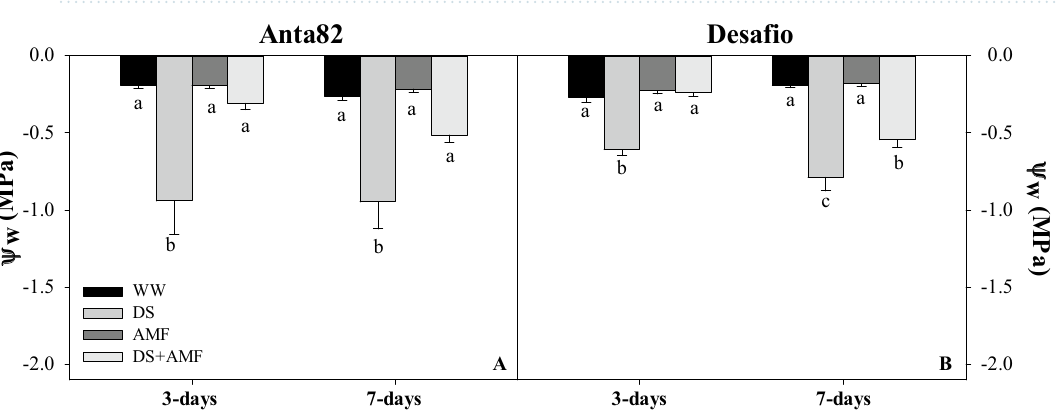
Figure 3. Water potential (Ψ w ) on days 3 and 7 in the ( A ) Anta82 and ( B ) Desafio soybean cultivars under different conditions of inoculation and water stress. WW = well-watered, noninoculated, DS = drought stress, noninoculated, WW + AMF = well-watered and inoculated, DS + AMF = drought stress and inoculated. The bars represent the mean ± SEM ( n = 4). Pairs of means in the same period (3 or 7 days) with different letters are significantly different ( p < 0.05) based on Tukey’s post hoc